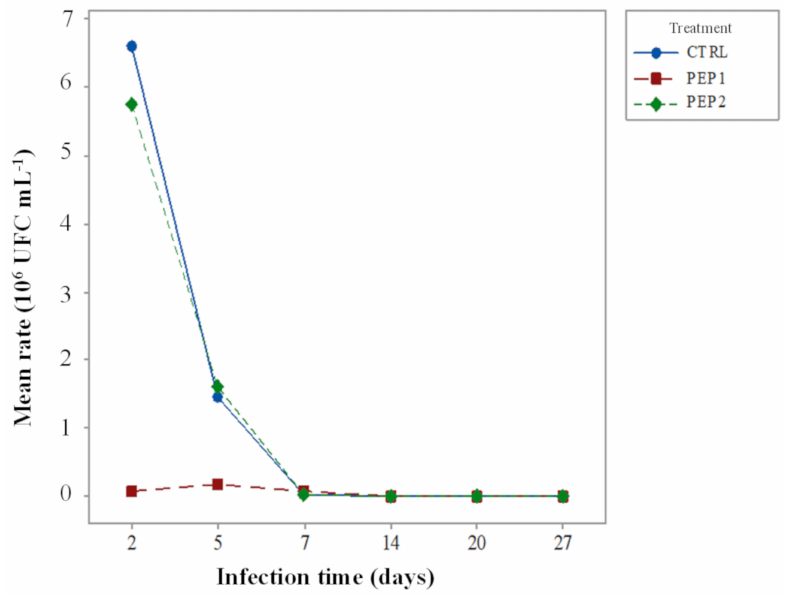
Figure 6. Mean count rate of S. Enteritidis, which is dependent on the treatments and time of